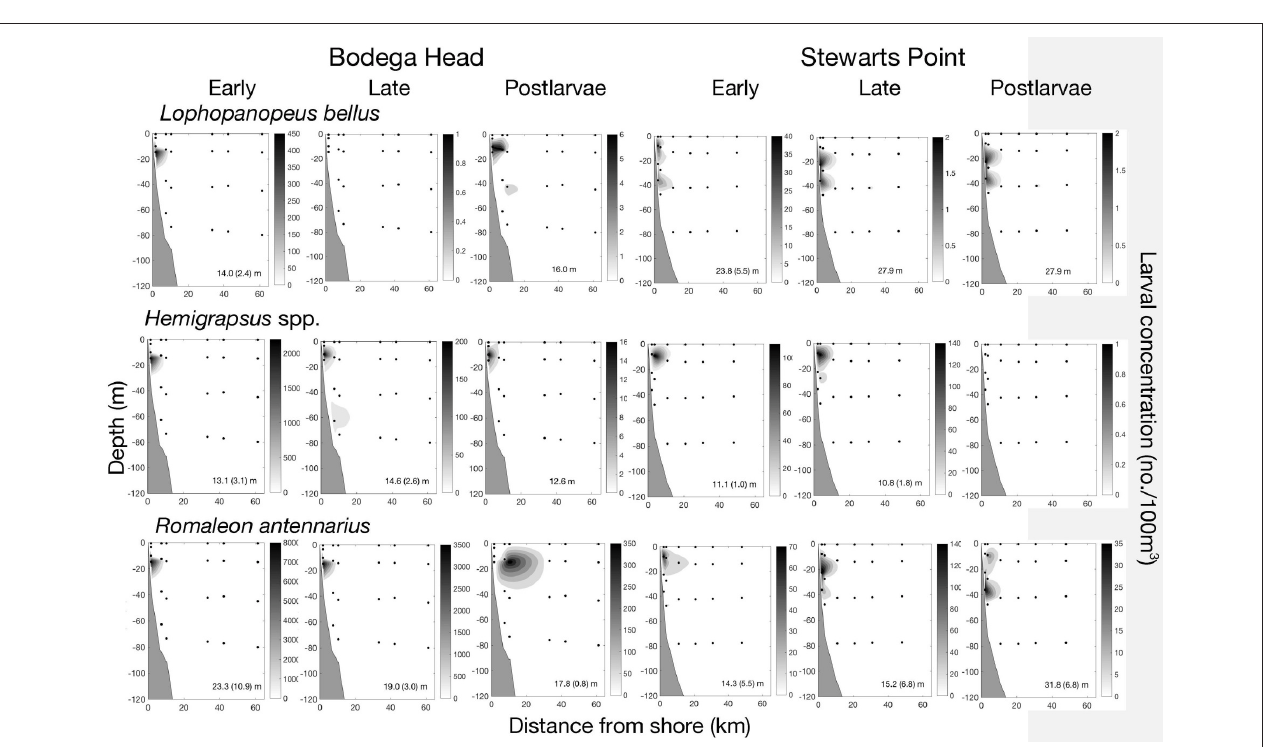
FIGURE 9 | Midshelf larval development of four species in relation to distance from shore and depth off Bodega Head and Stewarts Point where larvae largely occurred < 11km from shore with late stages primarily occurring < 32km. First row of panels for the xanthid crab Lophopanopeus bellus; second row of panels for two grapsid crabs ( Hemigrapsus oregonensis, H. nudus ); and third row panels for a rock crab Romaleon ( Cancer) antennarius . The depth center of mass (ZCM; mean with SE in parentheses) is given at the bottom of each panel. ZCM with no variation shown in parentheses indicates species were collected during a single cruise, and separate groups of larvae within panels were collected during different cruises. Missing panel indicates that small larvae passed through